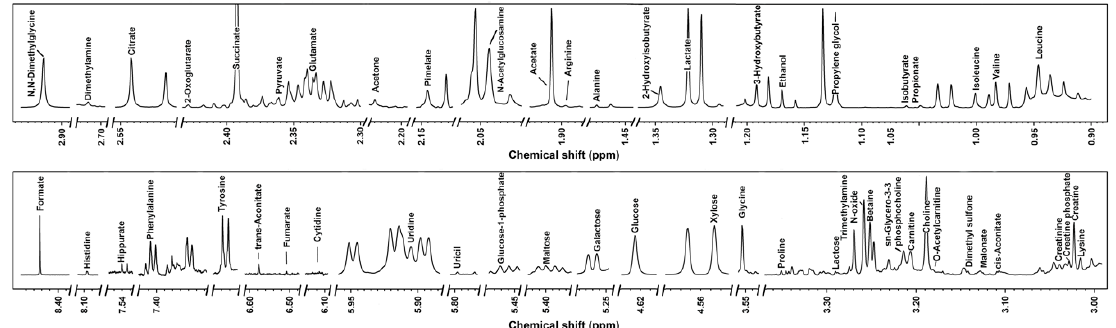
Figure 1. 1 H-NMR spectrum from one milk sample representative of all the registered spectra. The name of each molecule appears over the signal used for its quantification. To ease the reader’s visual inspection, for each portion a spectrum with a convenient signal-to-noise ratio has been selected. Table 1. Concentrations (mmol/L, median (IQR)) of molecules affected by clinical mastitis in milk samples.